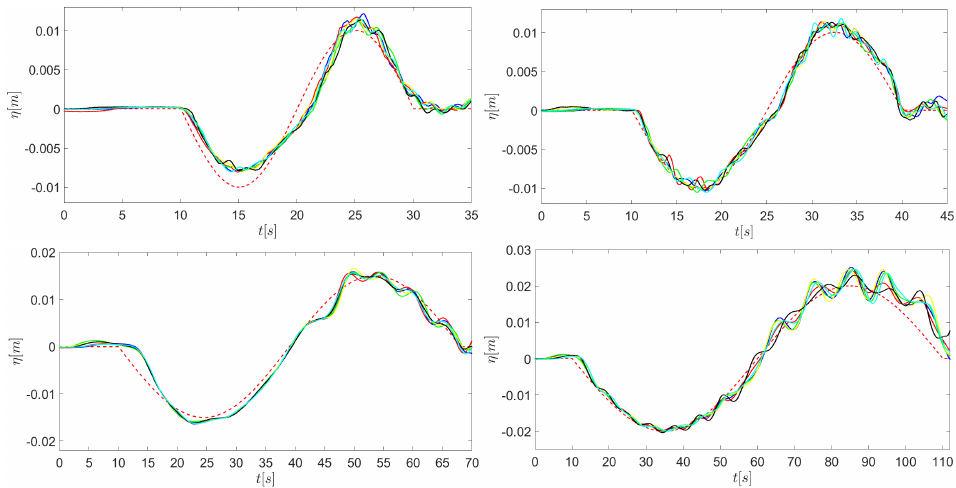
Figure 4. Time series of surface elevation for the reference curve (red dashed) and measured values (solid lines) for all six runs of T20_H2 ( top left ); T30_H2 ( top right ); T58_H3 ( bottom left ) and T100_H4 ( bottom right ) as measured by the pressure sensor at the water